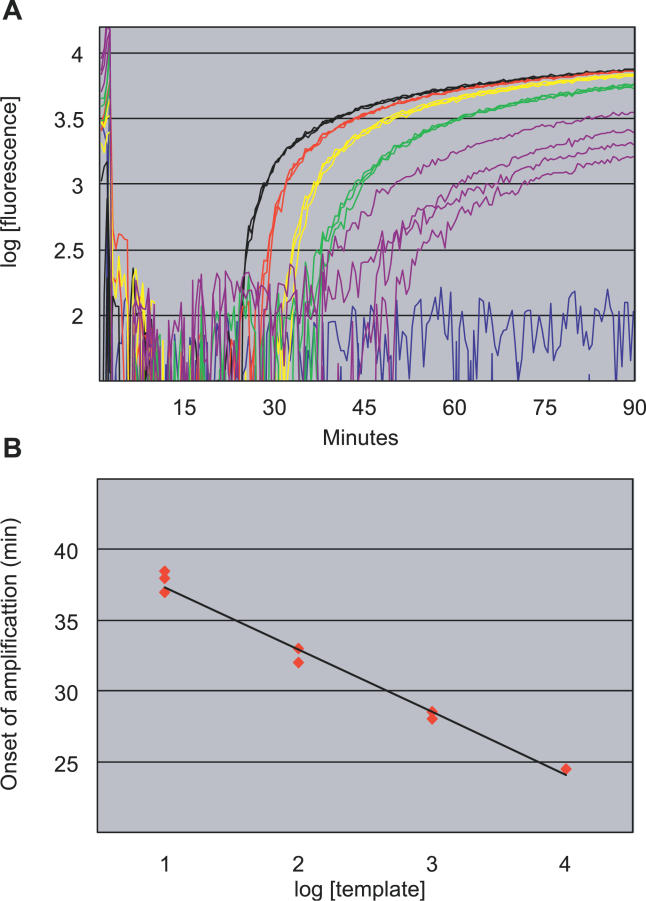
RPA Enables Specific DNA Amplification from Few Template Molecules(A) Probe signal of RPA reactions using the primer set orfX/sccIII (see
Figure 3). MRSAIII DNA at 10
4 (black, reactions 1–3), 10
3 (red, 4–6), 100 (yellow, 7–9), ten (green, 10–12), or two (purple, 13–17) copies or water (blue, 18–20) served as template.
(B) A plot of the onset time of amplification (defined as passing the 2.5 threshold) in reactions 1 to 12 in
Figure 4A against the logarithm of the template copy number reveals a linear relationship.